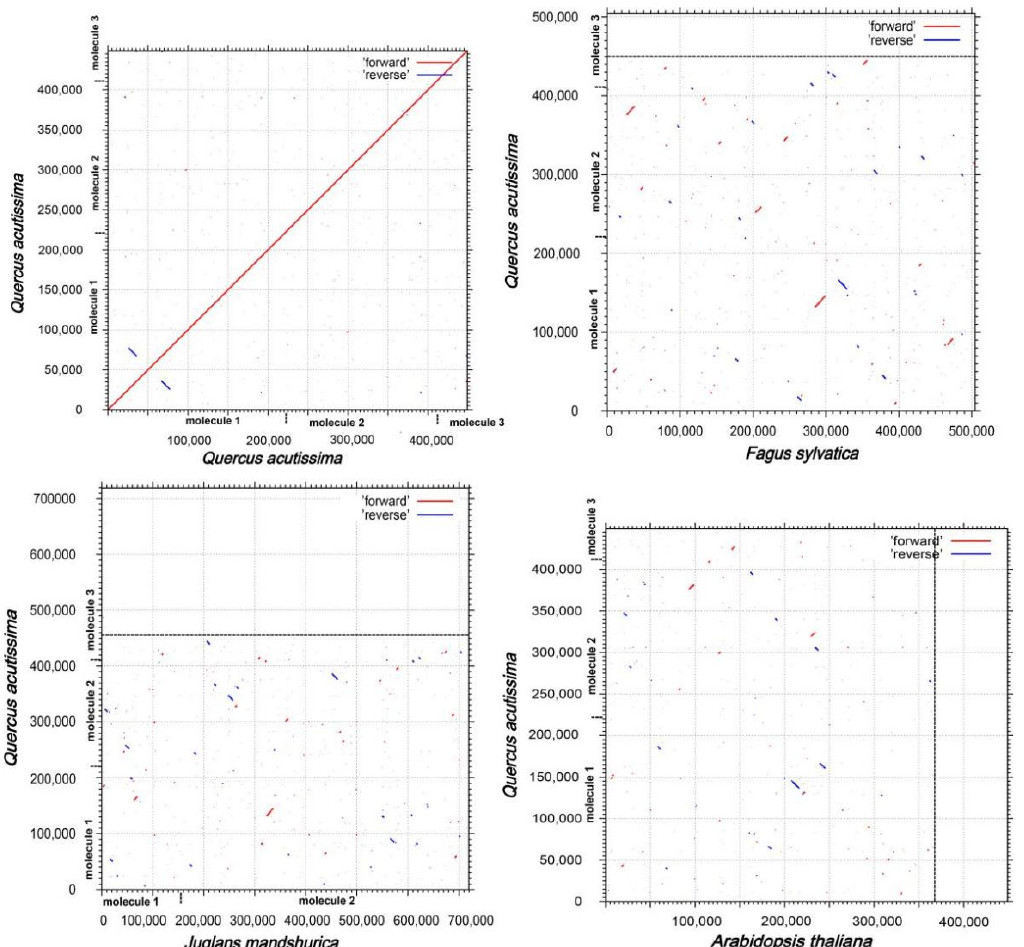
Figure 8. Dot-plots analysis. Self-dot plot of Q. acutissima is shown in the upper left corner, and the rest are dot plots of Q. acutissima with F. sylvatica , J. mandshurica , and A. thaliana .